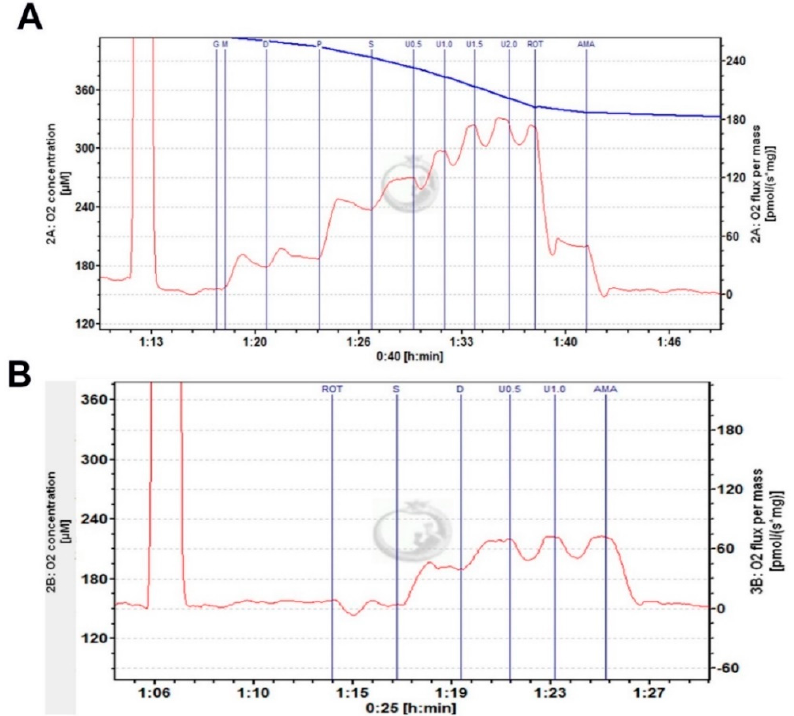
Figure 1. Representative respirometry traces of hippocampal homogenates using the Oroboros O2k-Respirometer. ( A ) Complex I and II linked activity. ( B ) Complex II linked activity. Complexes substrates as described in the methods.